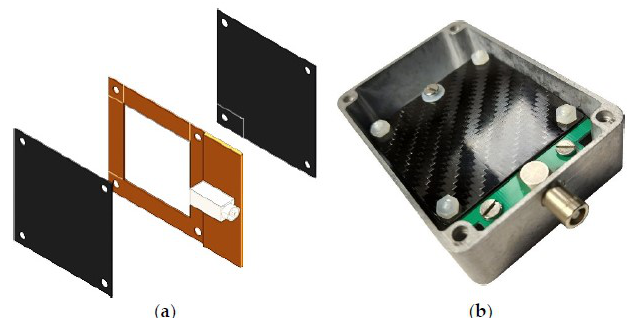
Fig. 2. (a) The SiLiF detector arrangement; (b) a real detector assembled inside its aluminium box.